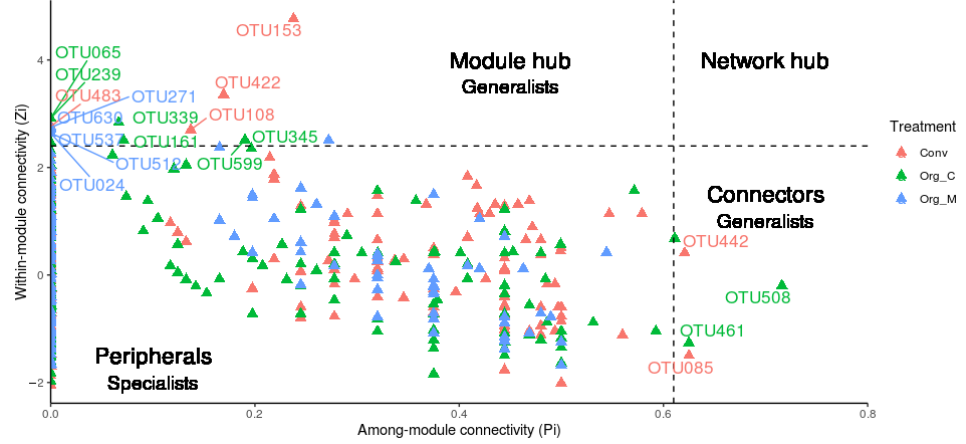
Figure 3. Zi-Pi plot showing the distribution of OTUs according to their topological roles. Each color represents the different cropping system nodes from the networks: Conv, conventional cropping system; Org_C, organic cropping system with compost and compost tea; Org_M, organic cropping system with manure; OTU065, OTU524, OTU161, OTU153, OTU108, OTU085, Actinobacteria; OTU239, Chloroflexi; OTU483, OTU537, OTU512, OTU422, OTU599, OTU442, OTU508, OTU461, Proteobacteria; OTU630, Verrucomicrobia; OTU271, Firmicutes; OTU339, NKB19, OTU345, Planc- tomycetes.